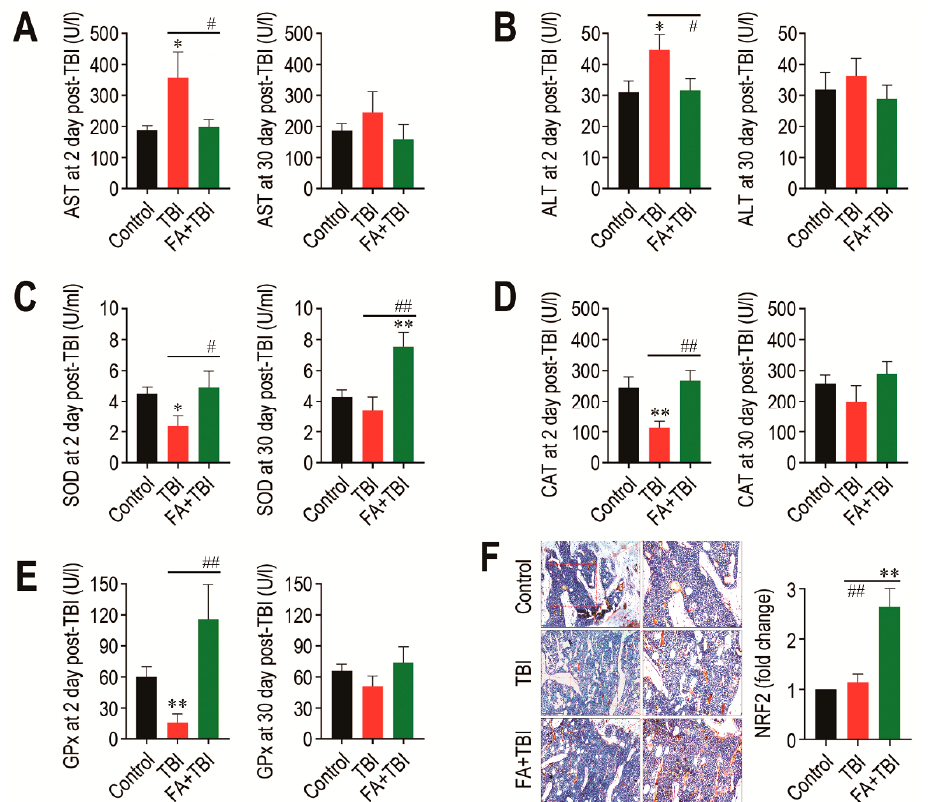
Figure 7. Long-term supplementation with ferulic acid prevents liver damage and increases the activities of liver-conserved antioxidant enzymes and the induction of NRF2 in BM of TBI mice. Levels of ( A ) AST and ( B ) ALT in blood serum of mice groups were determined 2 and 30 days after TBI. The activities of ( C ) SOD, ( D ) CAT, and ( E ) GPx in the liver from mice groups were determined 2 and 30 days after TBI. ( F ) Level of NRF2 in BM of mice groups was evaluated by IHC assay at 60 days post-TBI. Scale bar = 200 µ m. All data are presented as the mean ± SD ( n = 4). * p < 0.05 and ** p < 0.01 compared with control group; # p < 0.05 and ## p < 0.01 compared with TBI